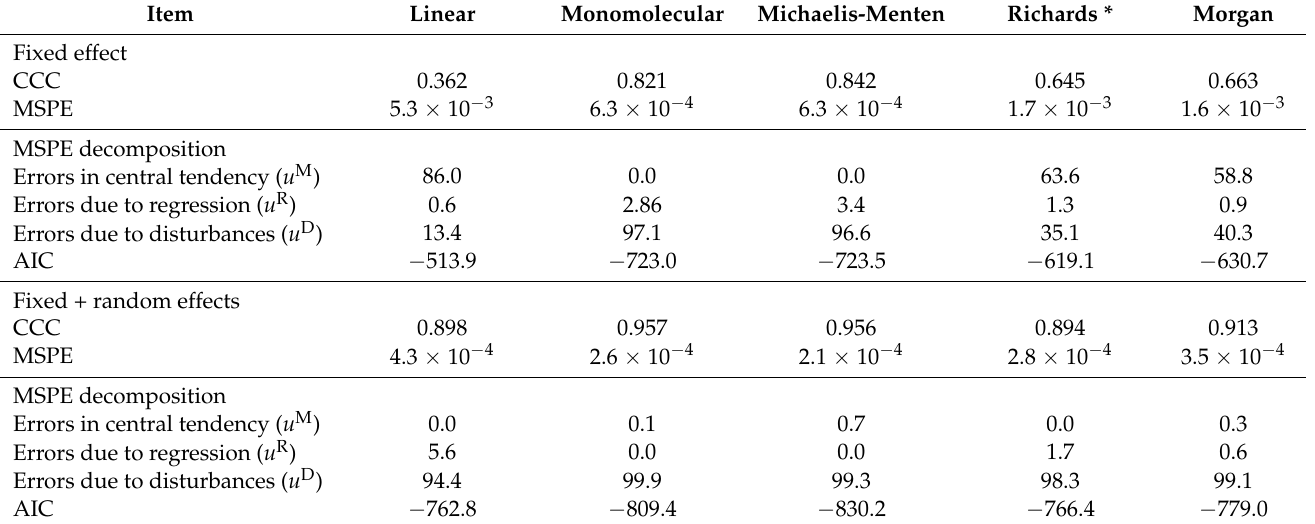
Table 3. Evaluation of models based upon goodness-of-fit and model selection criteria: concordance correlation coefficient (CCC), mean square prediction error (MSPE), its decomposition expressed as a percentage and Akaike information criterion (AIC), after fitting P retention vs. available P